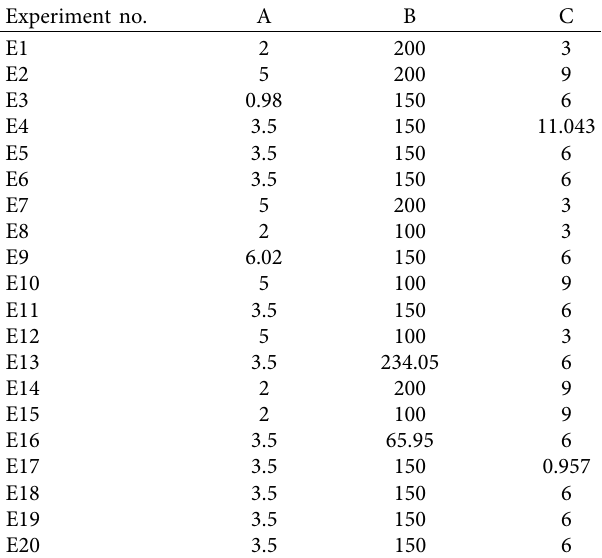
Figure 1: Morphology of (a) AlSi10Mg and (b) NbC. Table 2: CCD experiment design with